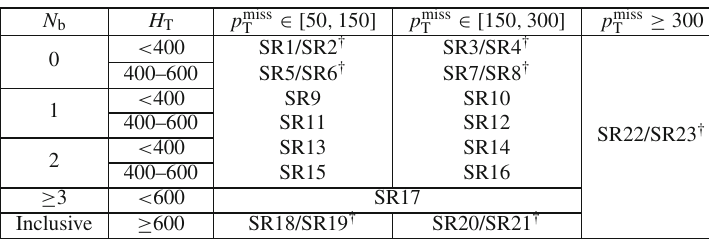
= 120GeV, with the high- m min region specified by the sec- by m min T T ond SR label. There are 23 regions in total. Quantities are specified in units of GeV where applicable.